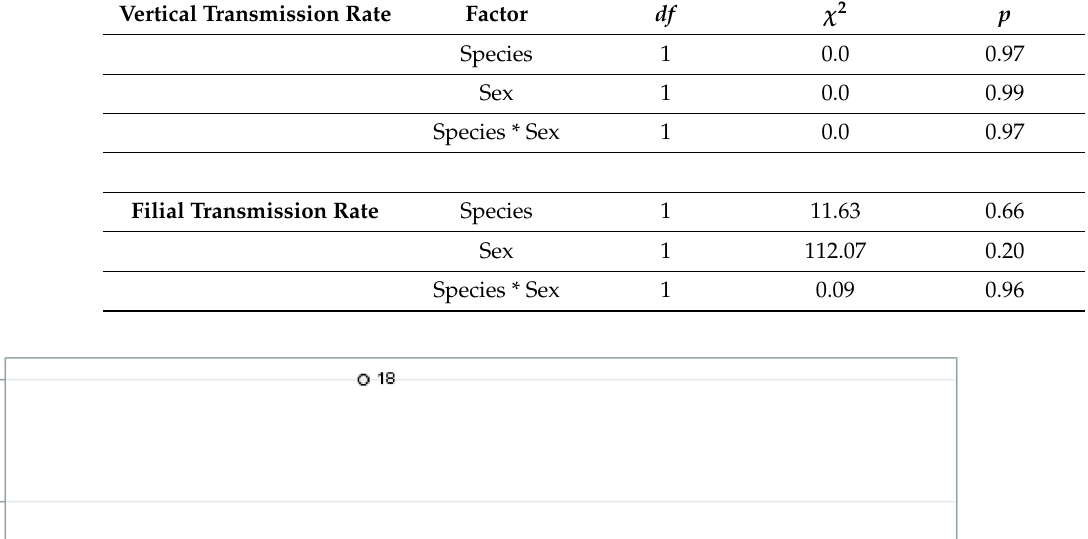
Table 3. Contingency table analysis of saliva expectorants of adult female progeny and whole-body assays of adult male progeny from infected parental Ae. aegypti and Ae. albopictus mosquitoes offered a Zika virus infected blood meal of 6 log 10 PFU/mL. The species by sex interaction is represented by Species * Sex.